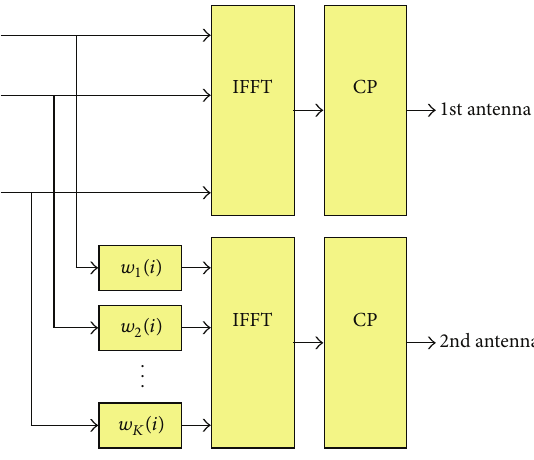
Figure 1: OFDMA system with phase